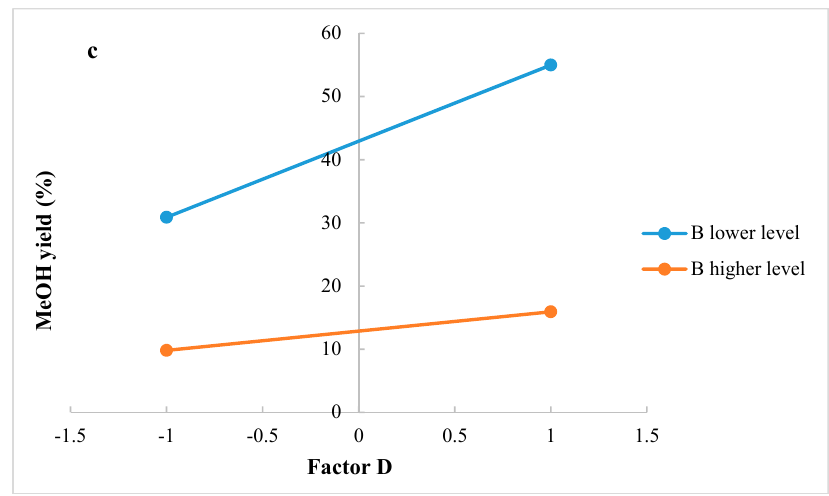
Figure 5. ( a ) Test of two levels for the analysis of interaction AC in methanol yield; ( b ) Test of two levels for the analysis of interaction BC in methanol yield ( c ) Test of two levels for the analysis of interaction BD in methanol yield. (A = CO composition in mol%, B = temperature in °C, C = recycle in %, D = water removal in %).